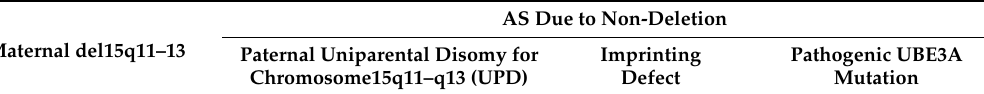
Table 2. Comparison of major phenotypes of different